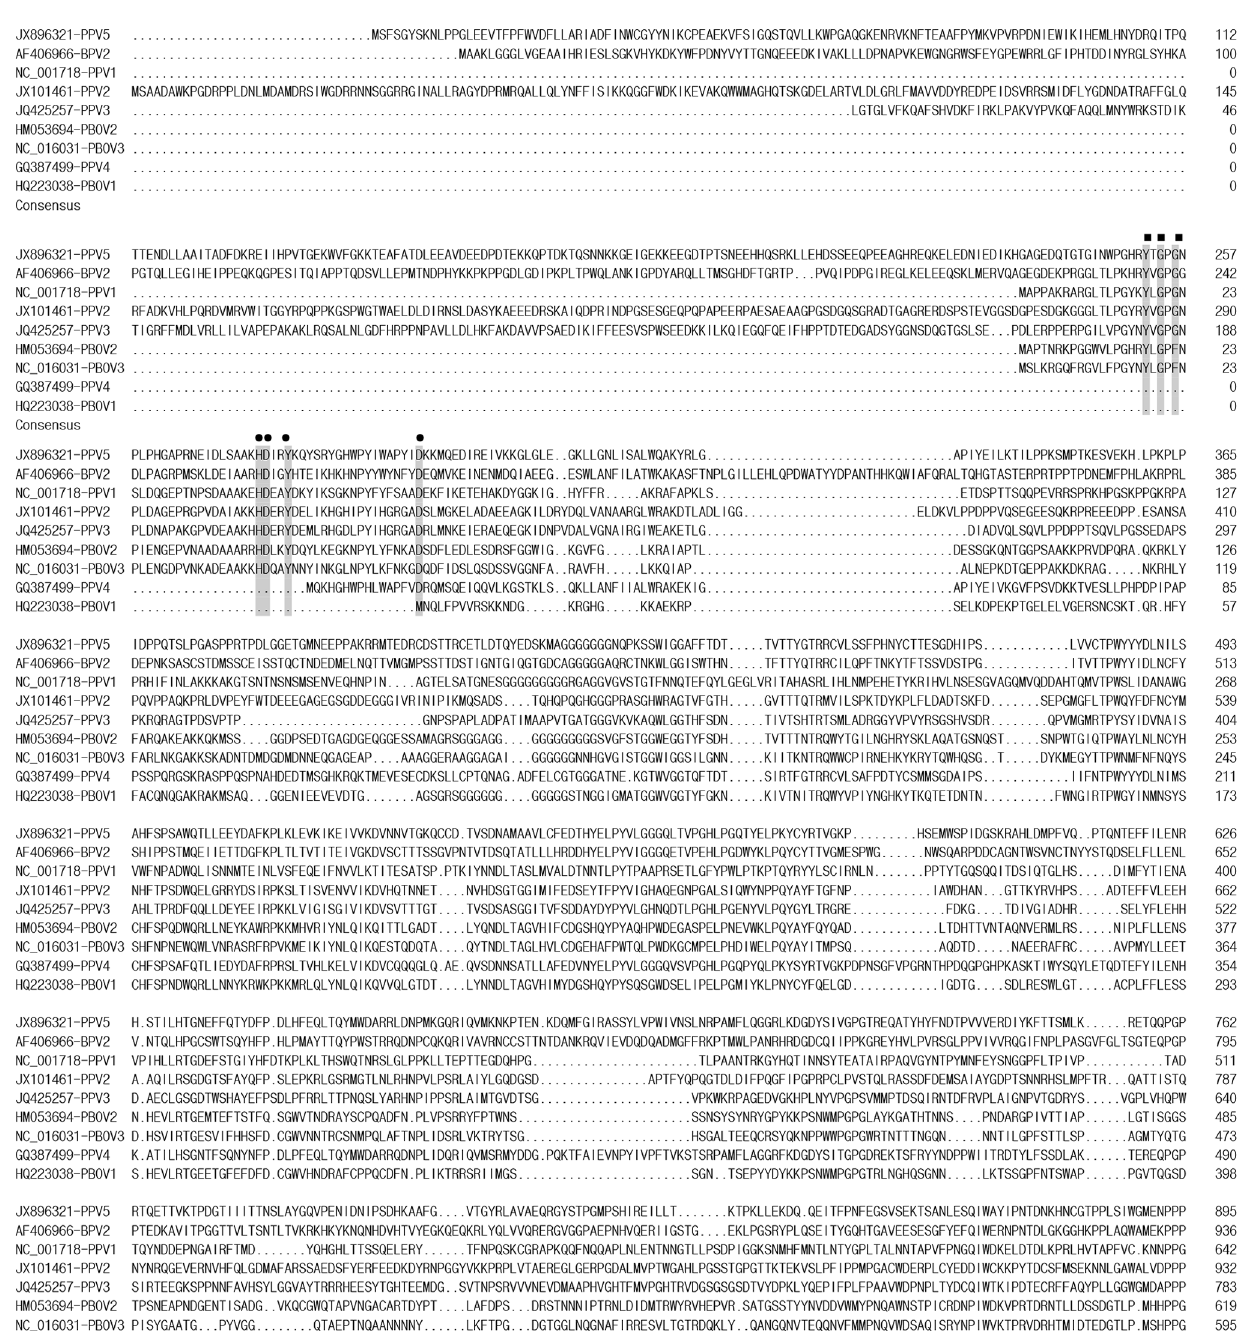
Figure 2. Amino acid sequence alignment of VP1 with the putative phospholipase A 2 motif of PPV5, other PPVs, PBoV, and BPV2. The Ca 2 + binding loop is indicated by filled squares and the catalytic residues are indicated by filled circles. ‘‘.’’ indicates a deletion compared to the strain on top. The positions of the amino acids and the GenBank numbers of the sequences are indicated.